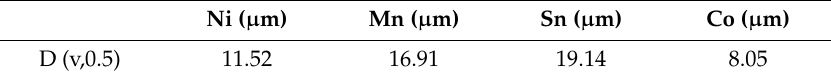
Table 1. Particle sizes of di ff erent